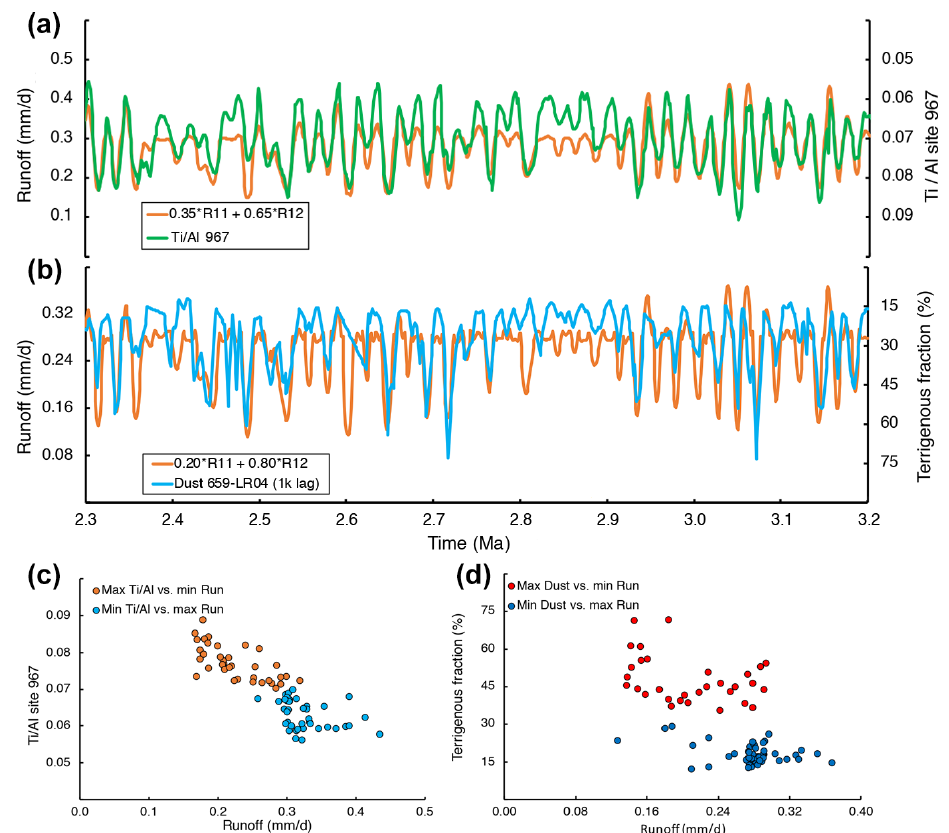
Figure 8. A comparison between CLIMBER-2 combined runoff output that correlates the highest as given in Fig. 7. (a) Combined runoff of 35% runoff 11 plus 65% runoff 12 (orange) and the Ti / Al record of Site 967 (green). (b) Combined runoff of 20% runoff 11 plus 80% runoff 12 (orange) and the dust record of Site 659 (light blue) re-tuned to the LR04 age scale. In (a) and (b) , for both sedimentary records the y axis is given on the right and is reversed. (c) A comparison of the high (orange) and low (light blue) peaks of Ti / Al versus runoff from panel (a) . Peaks are selected for Ti / Al values above and below 0.07. (d) A comparison of the high (red) and low (blue) peaks of dust versus runoff from panel (b) . Peaks are selected for dust values above and below 35.